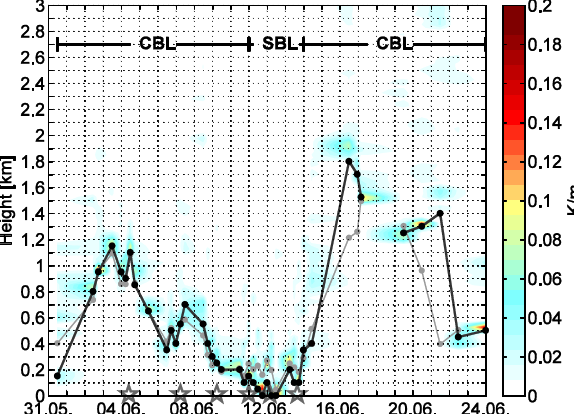
Fig. 5. Virtual potential temperature gradient (colour shading) with derived MABL heights (lines, in km). The black line shows the subjectively determined MABL height from temperature and humidity profiles, and the grey line is determined theoretically (Sect. 2.2). CBL and SBL identify convective and stable boundary layers. The 24h stations are marked with